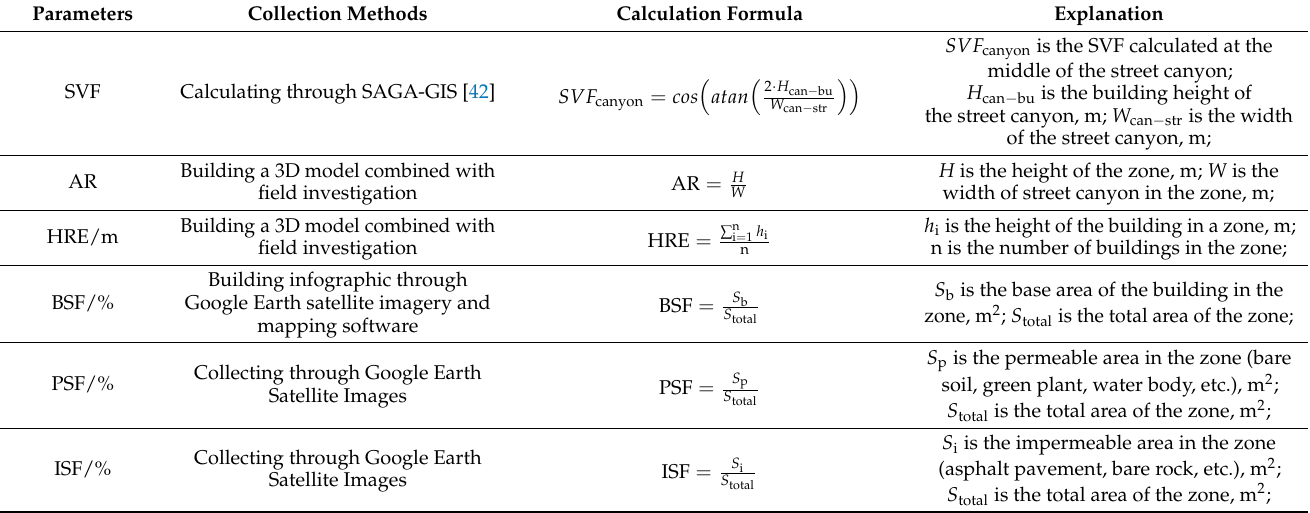
Table 3. Collection and calculation method of surface morphology characteristic